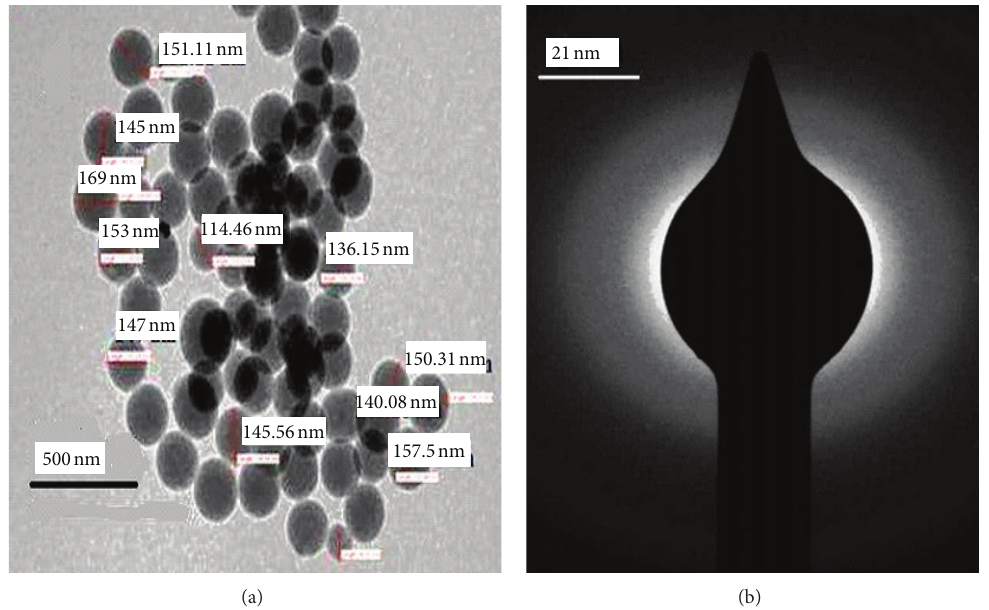
Figure 3: (a) TEM image and (b) SAED pattern of surface modified fluorescent silica nanoparticles. of dye-doped silica NPs occur at 480 nm and 535 nm.